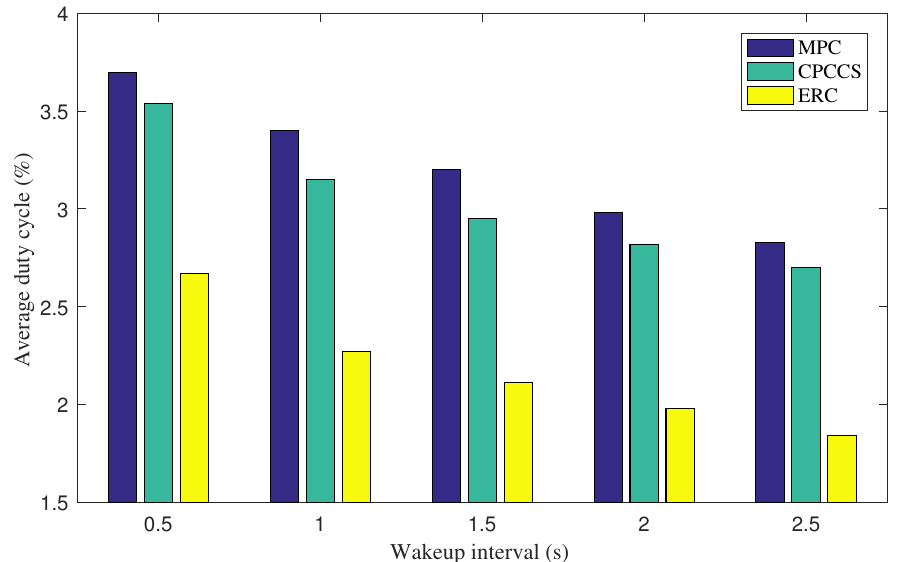
Figure 2. Average radio duty cycle under various wakeup intervals.